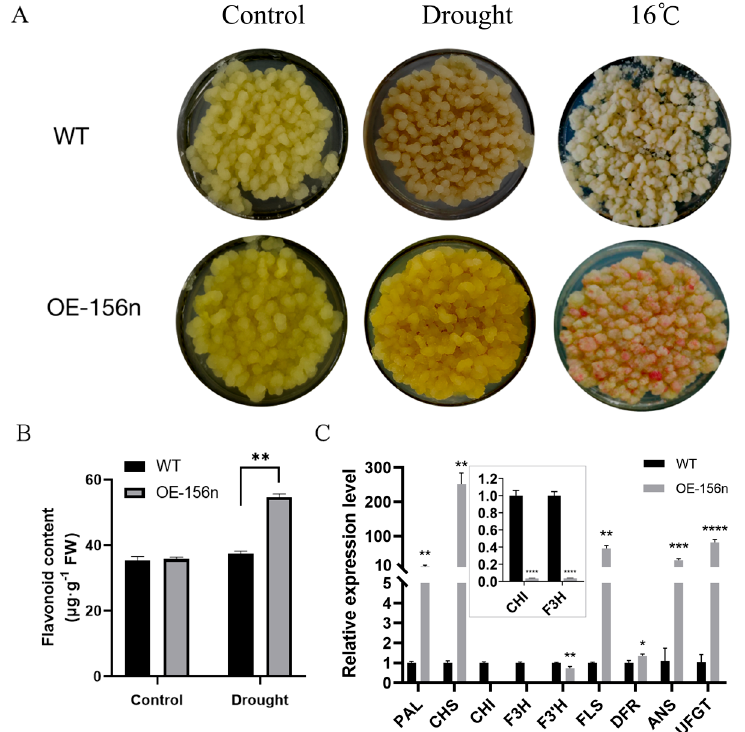
Figure 6. Mdmir156n is involved in the drought-induced accumulation of flavonoids and anthocyanins in apple calli: ( A ) Phenotypes of WT and OE-156n cultured under simulated drought stress. ( B ) Flavonoid content in WT and OE-156n transgenic apple calli under simulated drought treatment. ( C ) Expression analysis of the flavonoid biosynthetic pathway genes in WT and OE-156n. Values are means SD of three independent biological replicates. Asterisks indicate statistically significant differences (* p < 0.05, ** p < 0.01, *** p < 0.001, and **** p < 0.0001, one-way ANOVA).